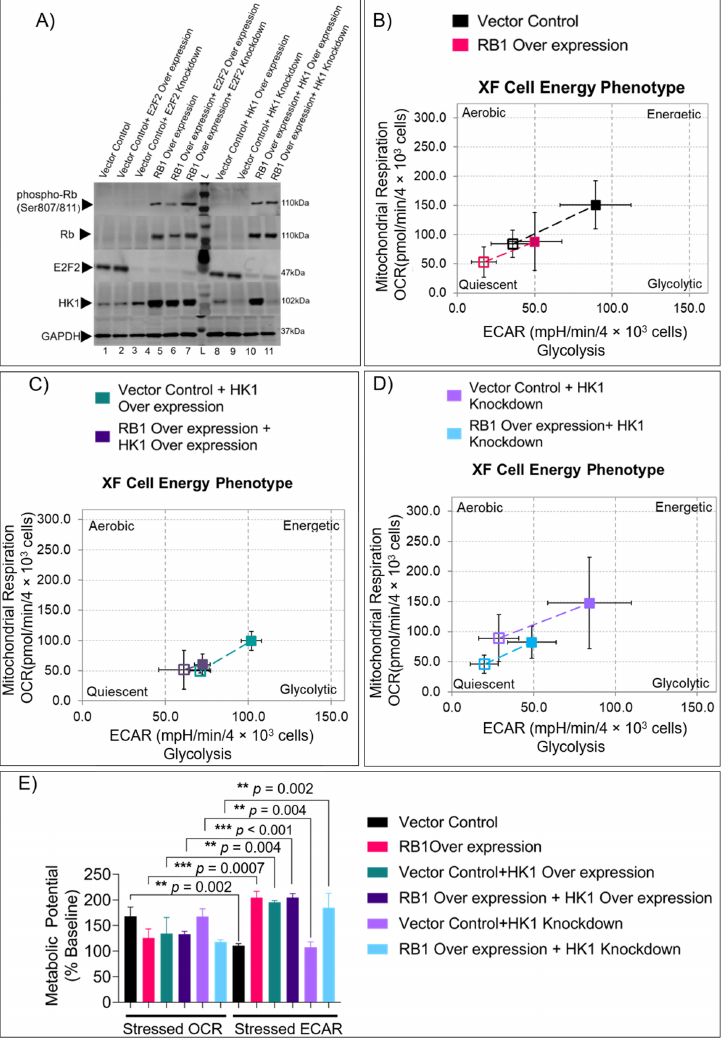
Figure 2. RB1 and HK1 complementation in Rb null cells reveals distinct energy profiles. ( A ) Western blot showing the protein expression of phospho ‐ Rb, Rb, E2F2, and HK1 in RB1 null and RB1 ‐ overexpressed (OE) WERI ‐ Rb1 cells modulated with E2F2 OE and HK1 OE and knockdown constructs. Energy phenotype profile of ( B ) vector control and RB1 ‐ overexpressed WERI ‐ Rb1 cells, ( C ) HK1 OE cells vs. RB1 OE+ HK1 OE WERI-Rb1 cells, and ( D ) HK1 knockdown vs. RB1 OE+ HK1 KD cells. ( E ) Metabolic potential of modulated cells under stressed phenotype. Open squares represent baseline activity, and closed squares represent stress-induced activity. Values represent three independent experiments mean with data points ± s.d. Kruskal–Wallis with Dunn’s multiple comparisons test (for >2 groups) were used for statistical analysis. ** p < 0.01, *** p < 0.001. OE = overexpression; KD =